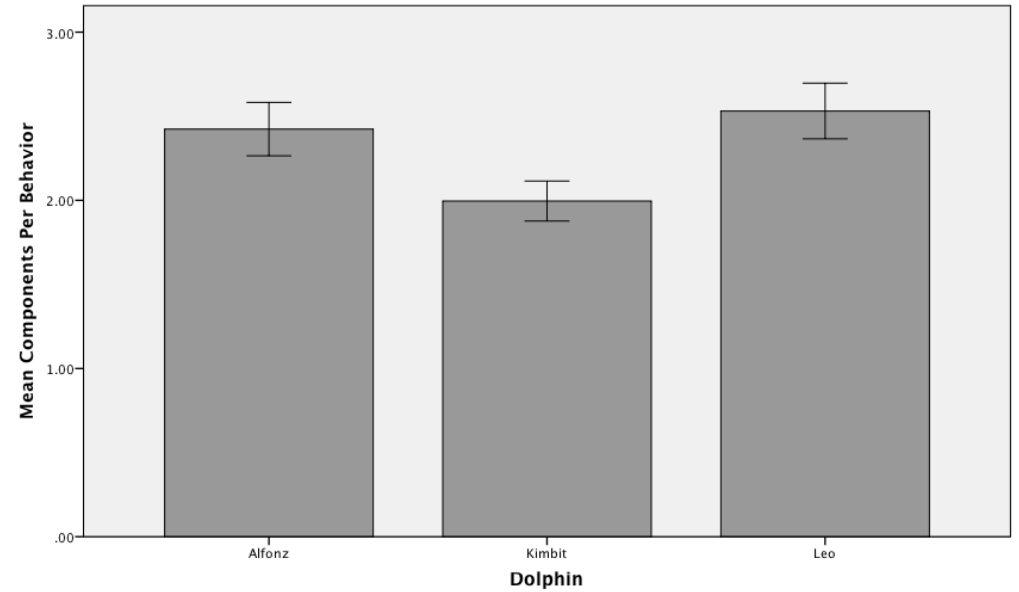
Figure 3. Mean number of different components used to “vary” each dolphin’s behavior during test sessions.